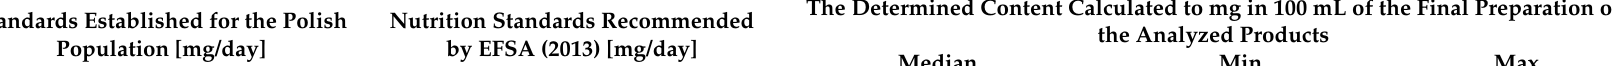
Table 3. The administration dose of the essential elements contained in a single portion of final preparation (mg/100 mL) in regard to the nutritional standards for the Polish population [28] and European Food Safety Authority (EFSA) recommendations [29]. Additional information on the qualitative and quantitative composition of all ingredients of the tested products, as declared by the manufacturer, is provided in Table S1(a–c) in the Supplemental